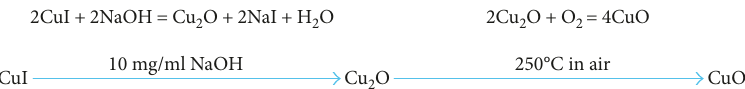
Figure 8: Preparation process for Cu